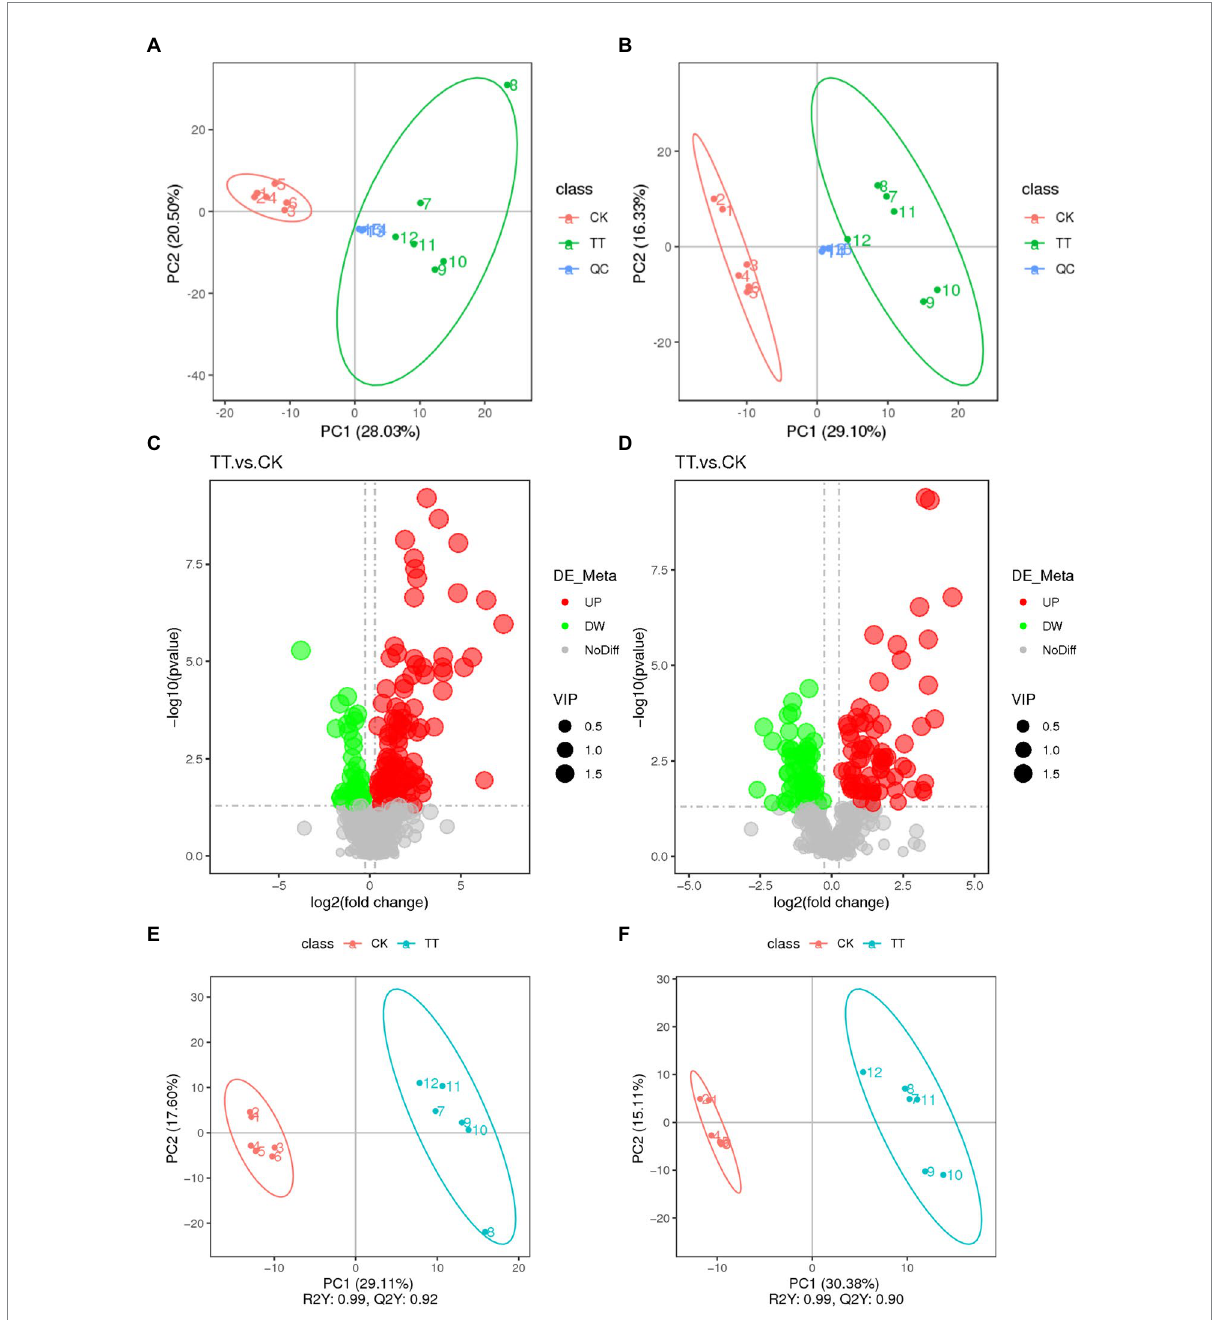
FIGURE 3 Multivariate statistical analysis of untargeted metabolomics data obtained using the LC–MS/MS approach. PCA score plot of cecum metabolomics data for control and LNT addition (TT) obtained by (A) LC-MS (ESI − ) and (B) LC-MS (ESI+) ( n = 6). (C) PLS-DA score plot of cecum metabolomics data obtained by LC-MS (ESI − ); R 2 Y = 0.99; Q 2 Y = 0.90. (D) PLS-DA score plot of cecum metabolomics data obtained by LC-MS (ESI+); R 2 Y = 0.99; Q 2 Y = 0.92. (E) Score plot of LC-MS (ESI − ) data signals detected. (F) Score plot of LC-MS (ESI − ) data signals detected. Red circles in volcano plots are model-separated metabolites following the conditions of VIP